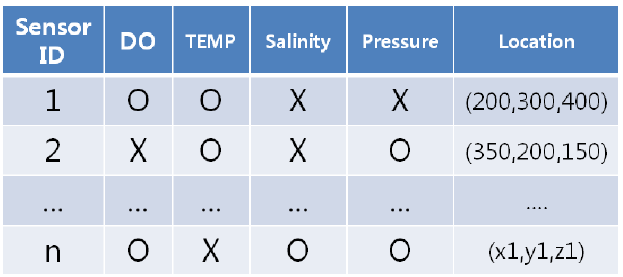
Figure 4. Example of a network dictionary possessed by a